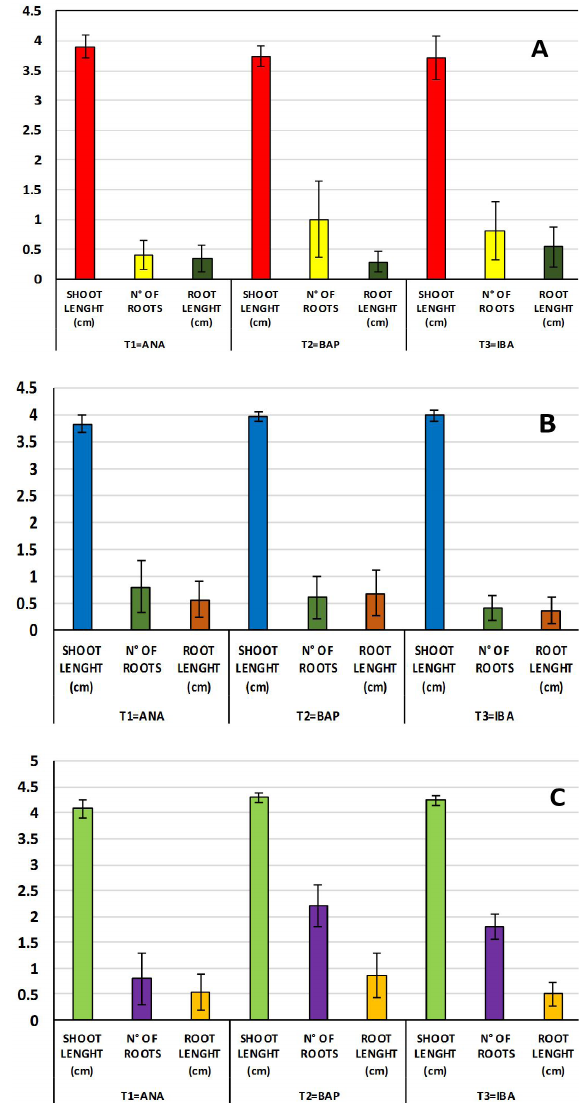
Figure 6. Effect of growth regulators on root development of shoots in three clonal lines of thorny artichoke ( Cynara scolymus L.) in the rooting stage. (A) L-132, (B) L-200, and (C) L-250. Values are means ± SE (n = 10).